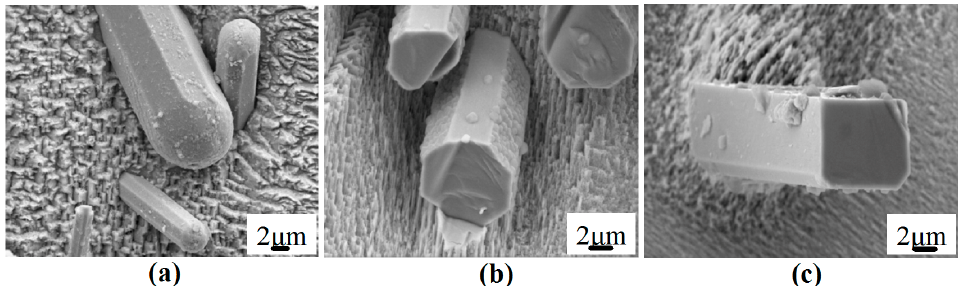
Figure 2. Deep-etched SEM image of ( a ) spherical-capped, ( b ) truncated octagonal-based and ( c ) truncated Figure 2. Deep ‐ etched SEM image of ( a ) spherical ‐ capped, ( b ) truncated octagonal ‐ based and ( c ) square-based MnSn 2 crystals, truncated square ‐ based MnSn 2 crystals, respectively.